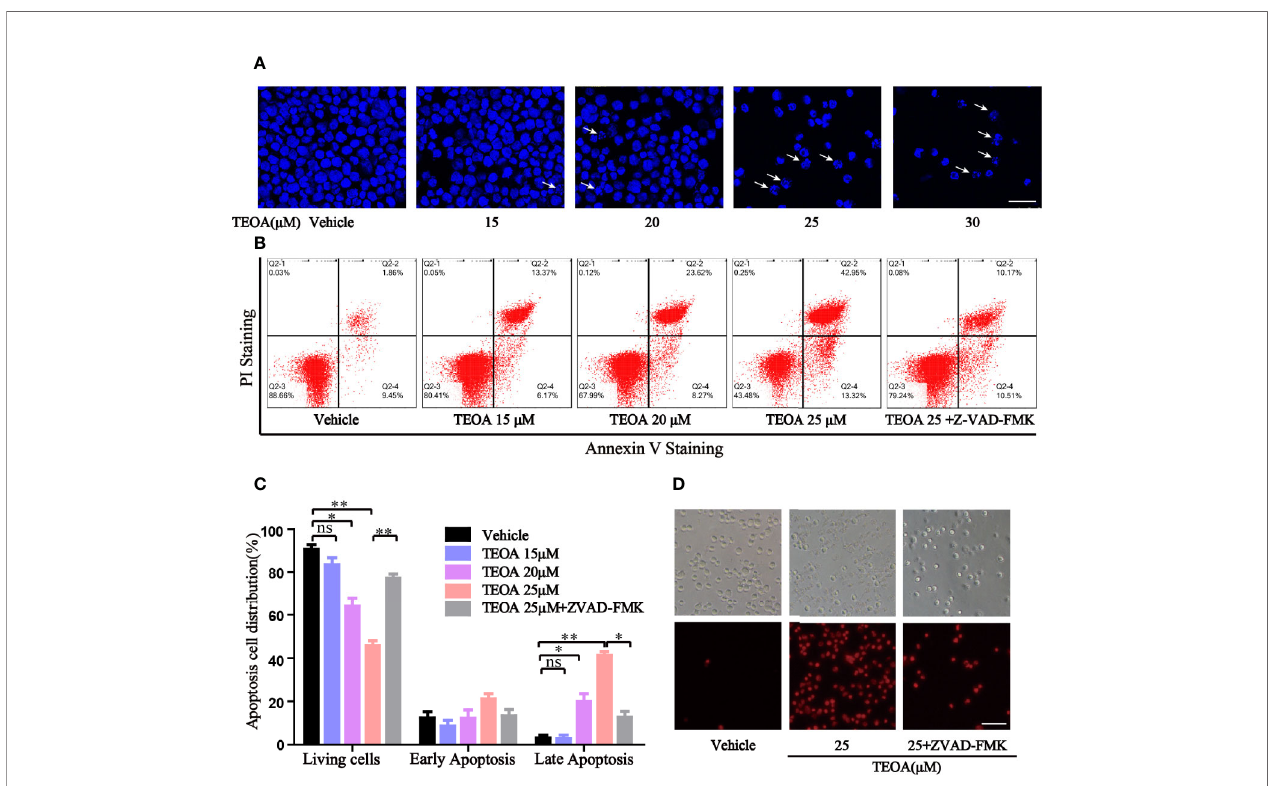
FIGURE 2 | TEOA induced apoptosis in diffuse large B-cell lymphoma (DLBCL) cells. (A) OCI-LY10 cells treated with indicated concentration of TEOA for 12 h were stained with Hoechst 33258, and the nuclear fragmentation was indicated with white arrows; scale bar: 40 µm. (B, C) OCI-LY10 cells were pretreated with or without z-VAD-FMK (5 m M) for 1 h, then treated with different concentrations of TEOA for 12 h; the results were analyzed by fl ow cytometry with Annexin V-FITC/PI apoptosis kit. The proportion of apoptotic cells was presented by GraphPad Prism5; * P <0.05, ** P <0.01. (D) OCI-LY10 cells were treated with 25 m M TEOA in